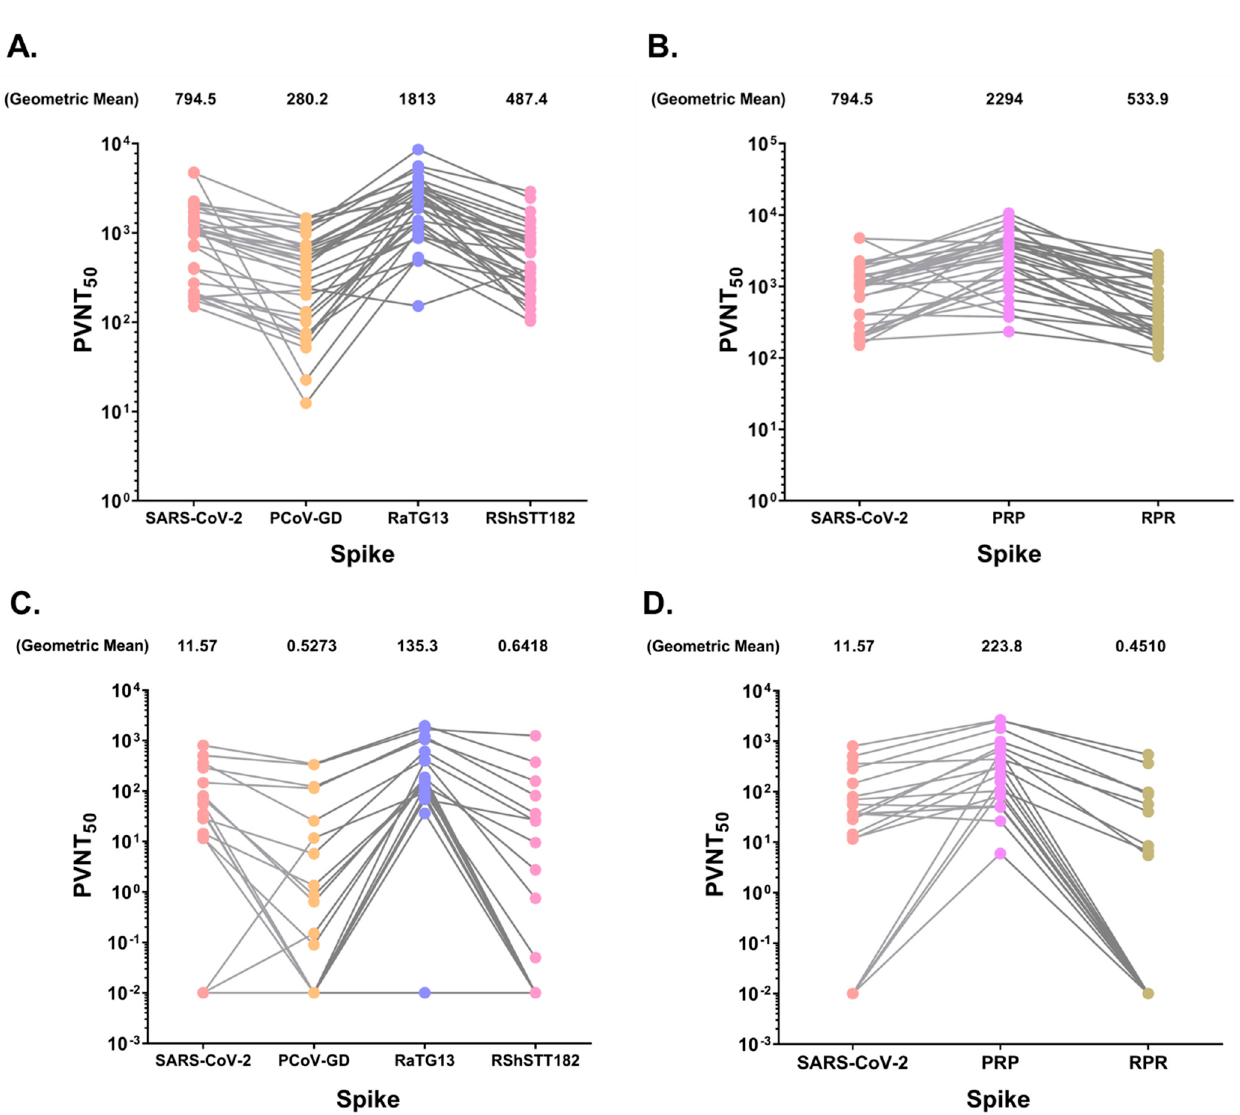
Figure 5. Analyses of the cross-neutralization activity of SARS-CoV-2-positive serum samples against pseudo-viruses carrying each sarbecovirus spike. ( A ). Neutralization titers against SARS-CoV-2, PCoV-GD, RaTG13, and RshSTT182 in 31 convalescent donors. ( B ). Neutralization titers of convalescent sera against pseudo-viruses carrying a chimeric PRP and RPR spike. ( C ). Neutralization titers of 20 donors vaccinated with CoronaVac against SARS-CoV-2, PCoV-GD, RaTG13, and RshSTT182 one month after vaccination. ( D ). Titers of neutralization of vaccinated sera against pseudo-viruses with chimeric PRP and RPR spike. The geometric mean of each data set is shown in all analyses.